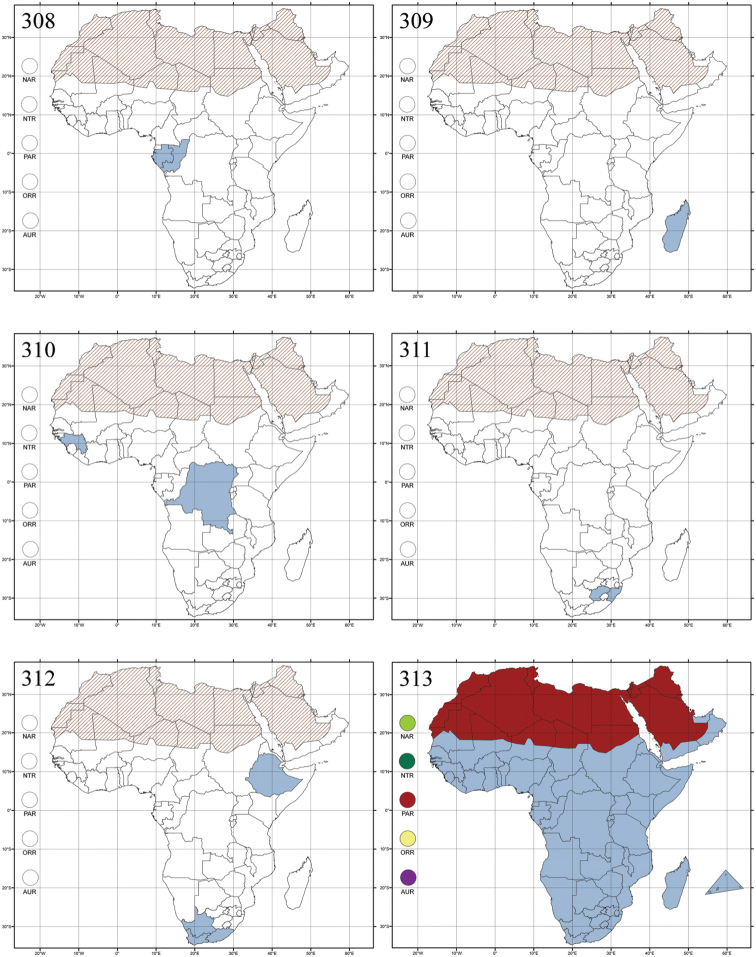
Maps of distribution. 308
Dimonikaea Bechyné 309
Diphaulacosoma Jacoby 310
Djallonia Bechyné 311
Drakensbergianella Biondi & D’Alessandro 312
Dunbrodya Jacoby 313
Epitrix Foudras.